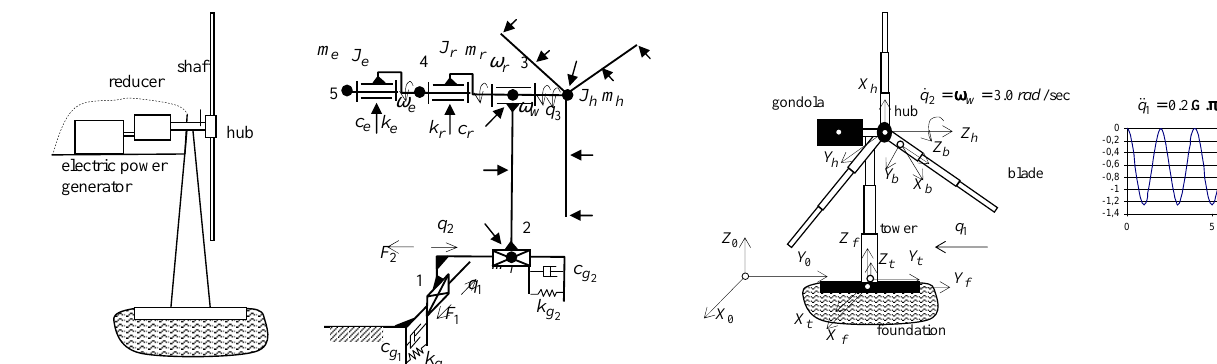
Figure 4. A design scheme and the discretized structure of a wind power generator.